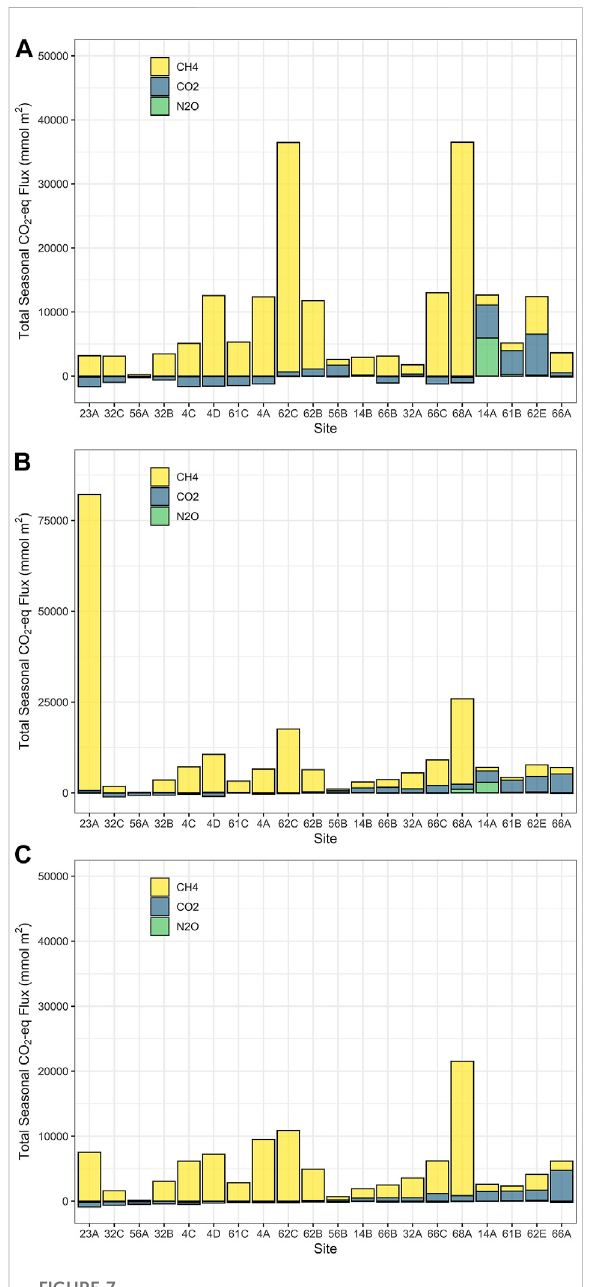
FIGURE 7 Calculated CO 2 -eq fl uxes based on three differentestimates: (A) Using GHG fl uxes measured in July and extrapolating over the entireopen-water season; (B) Using GHG fl uxesmeasuredonfour dates (April, May, July and Sept) in 2018 and interpolating betweensamplingdates; (C) Meanpredicted fl uxusingGAMsfrom Figure 1 to interpolate gas fl ux between sampling